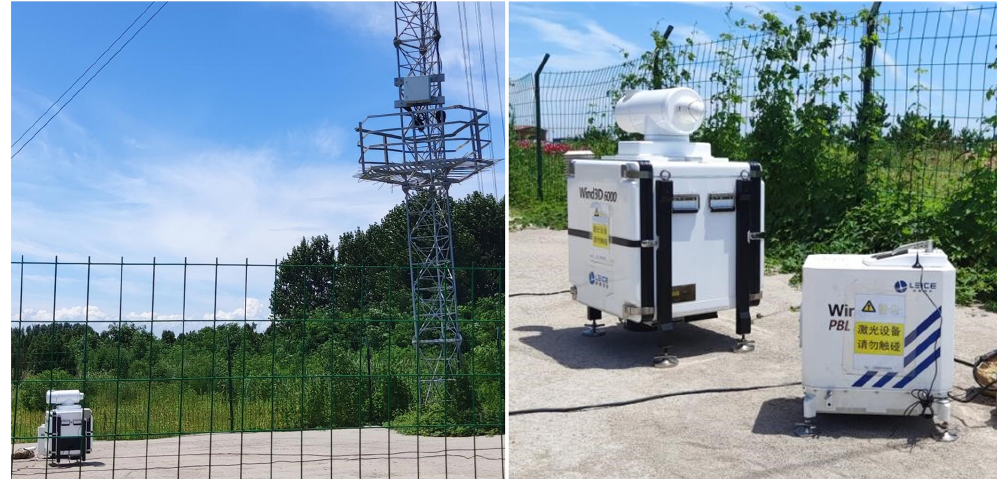
Figure 2. Photos of the CDLs and the mast onto which the cup anemometers and the wind vines were mounted at the Haiyang site.